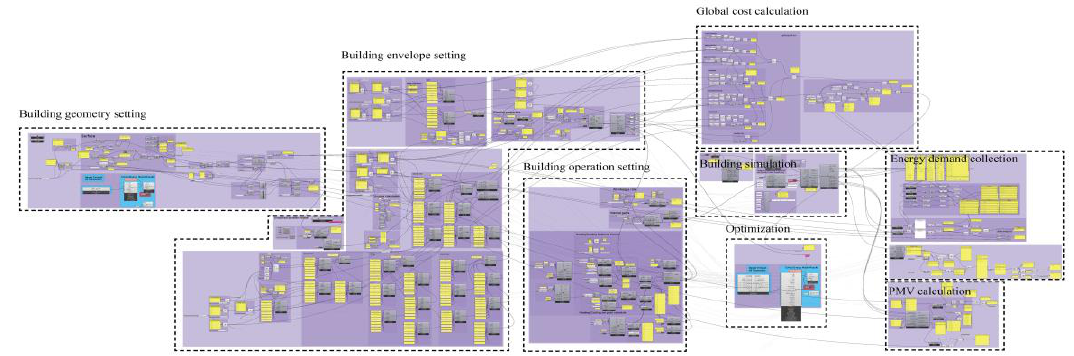
Figure 12. Grasshopper operation process.